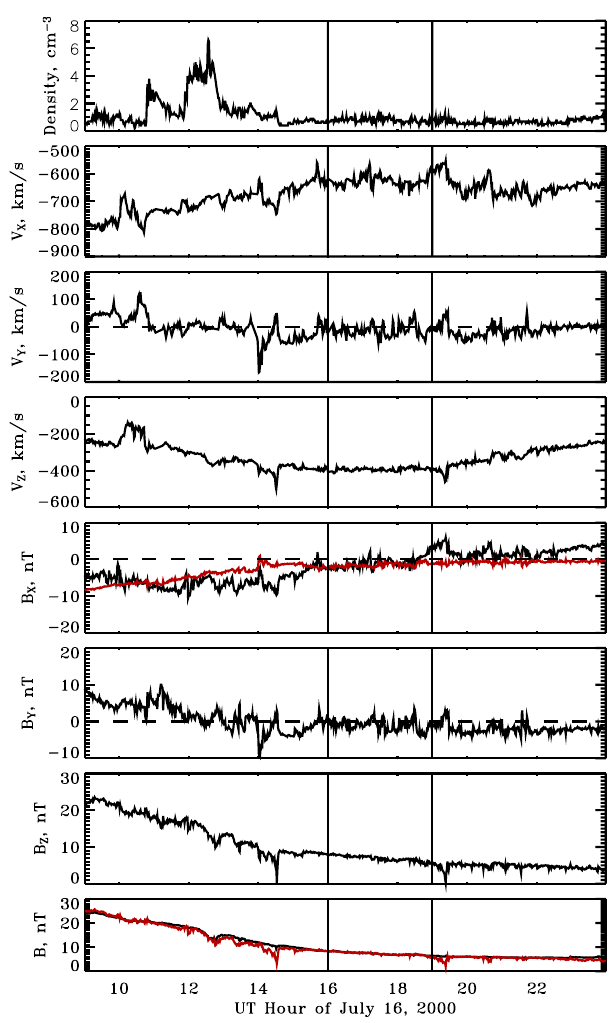
Fig. 1. Solar wind plasma and IMF data observed by ACE in SM coordinate system. The vertical lines at 16:00 UT and 19:00 UT denote the period during which comparisons are made. The red trace in the 5th panel shows B X =− 0 . 2802 B Y − 0 . 2712 B Z and in the last panel – the corresponding total magnetic field. See text for